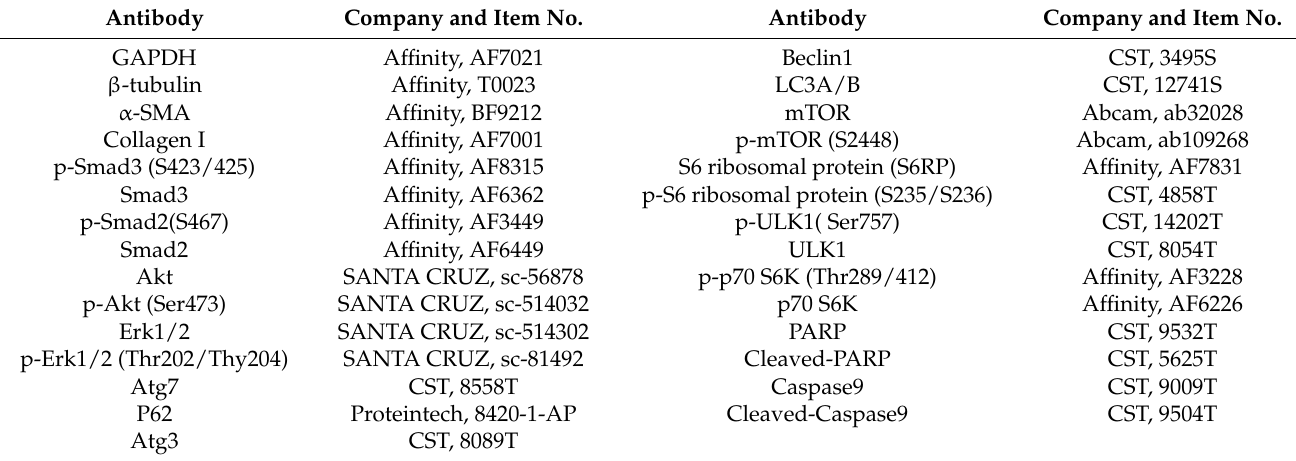
Table 1. The list of primary antibodies.